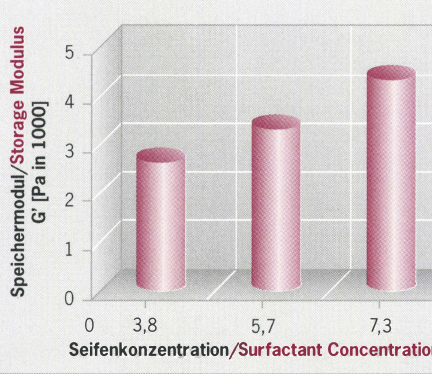
Abb. 3: Elastisches Verhalten zweier untersuchter Schmierfette bei unterschiedlichen Temperaturen Fig. 3: Elastic behavior of two greases with different surfactant concentrations examined at different temperatures